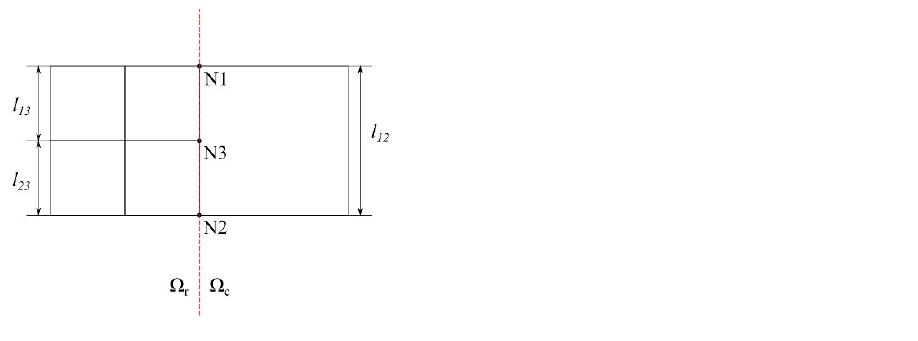
Figure 5. An example of the boundary nodes between two domains of mesh refinement, where N3 is a hanging node.